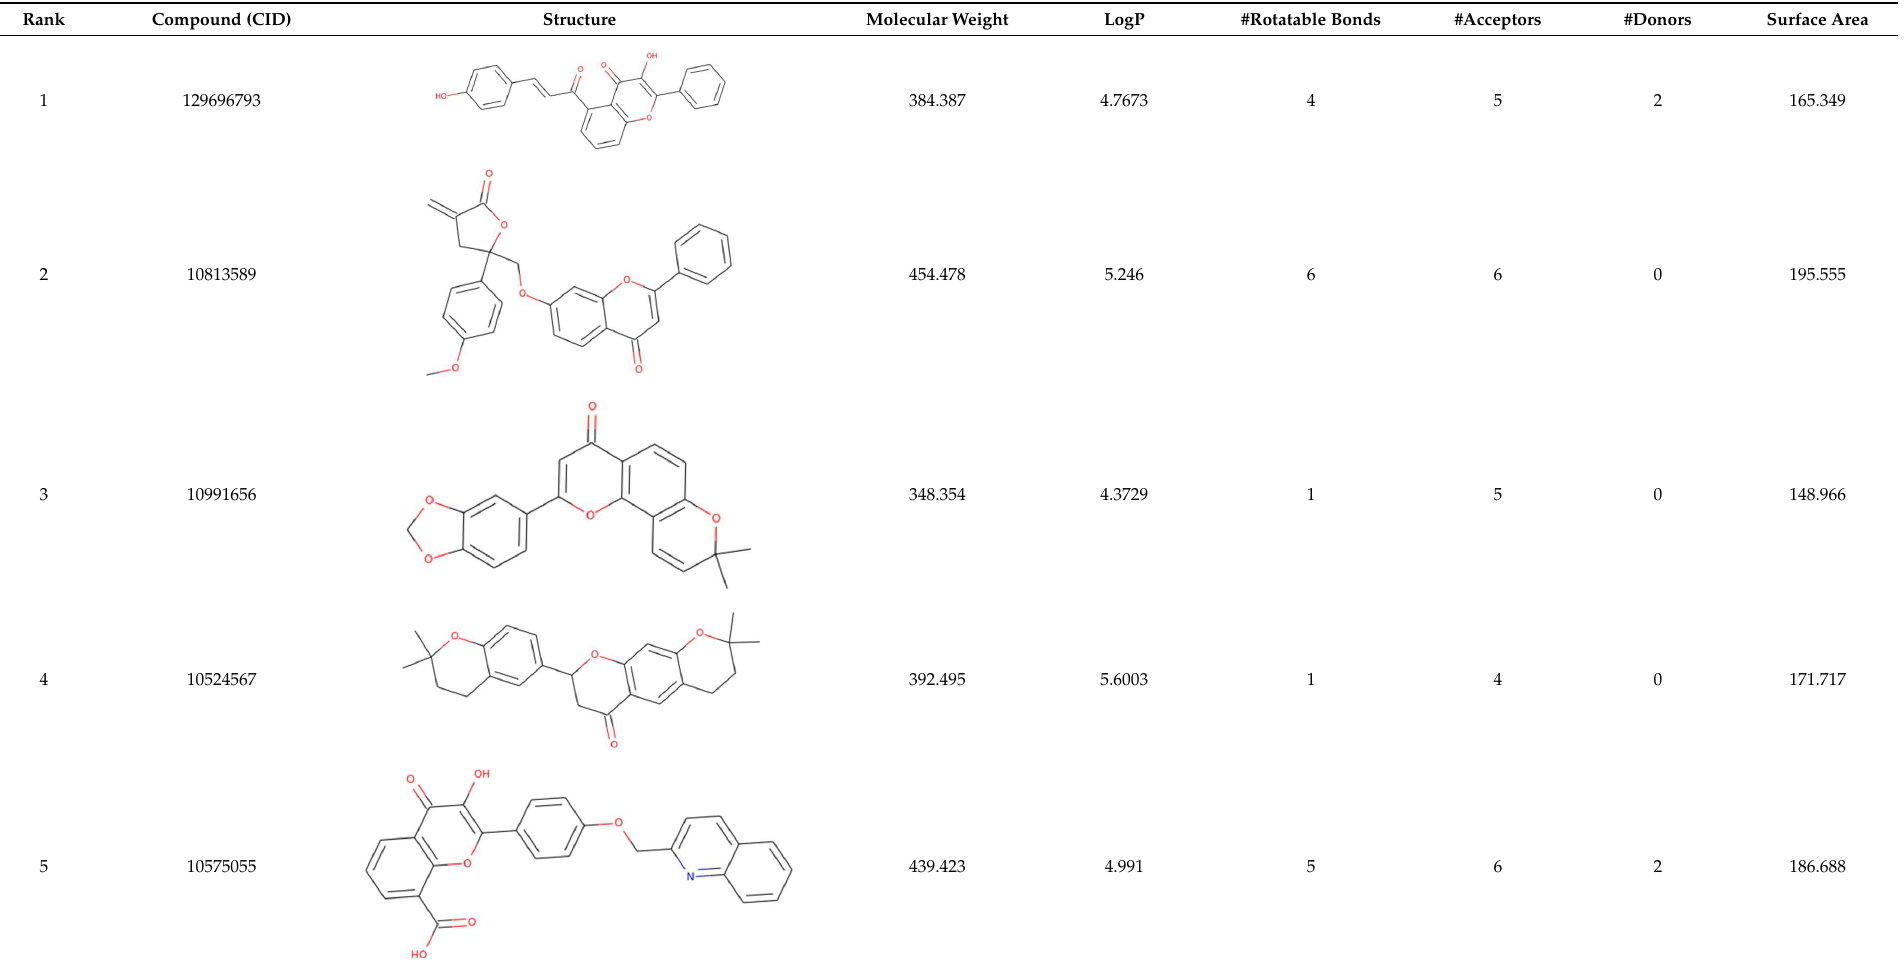
Table 7. Structures and chemical properties of the selected flavonoids against MEK1 to predict the drug-likeness: molecular weight, lipophilicity (LogP), number of (#) rotatable bonds, hydrogen acceptors and hydrogen donors, and polar surface area.